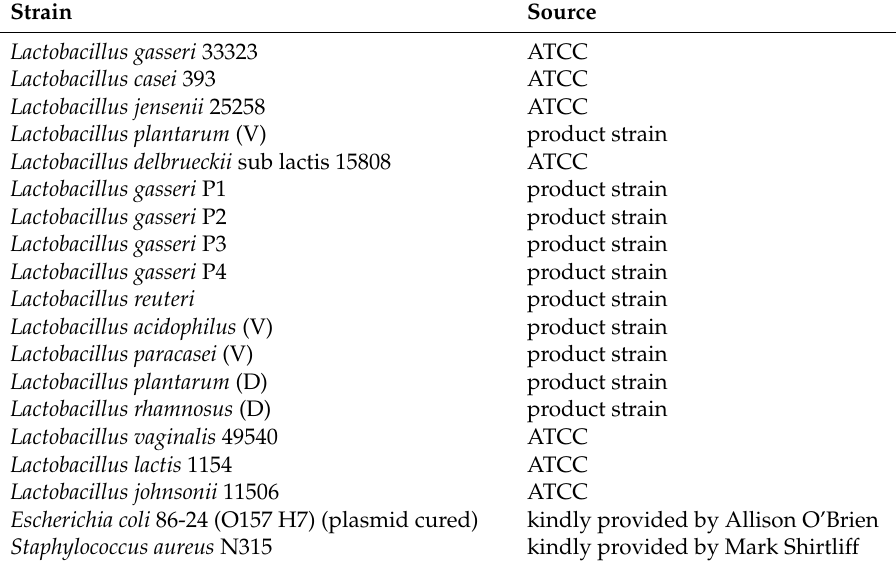
Table 1. List of strains used in our lytic activity screen and mock purity/spiking